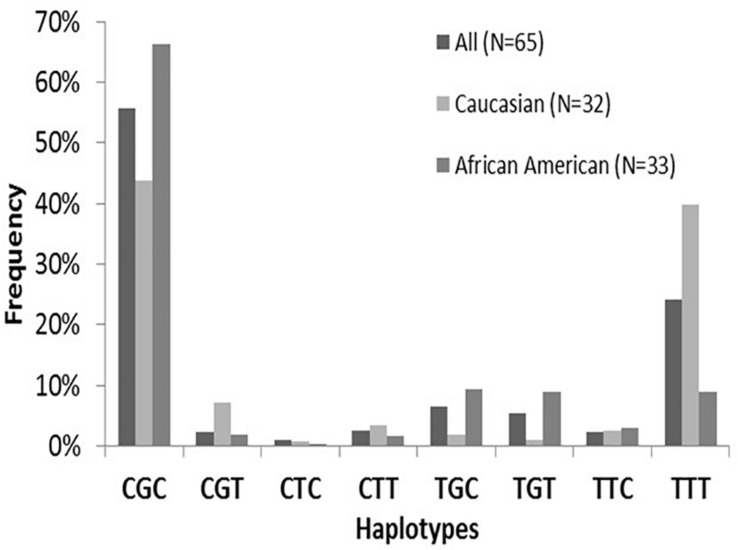
ABCB1 haplotype frequencies by Race. Note the distributions of ABCB1 wild-type CGC compared to variants. The frequency of the major variant is TTT is depicted with a frequency of 39.8% in Whites compared to 8.9% in Blacks. There were significant overall differences (p < 0.001) for haplotype frequencies between Whites and Blacks attributed to CGC and TTT (brackets). This finding is consistent with previously evaluated populations (29–31). No differences in haplotype frequencies are found between sexes. Figure from Venuto et al. (2015).